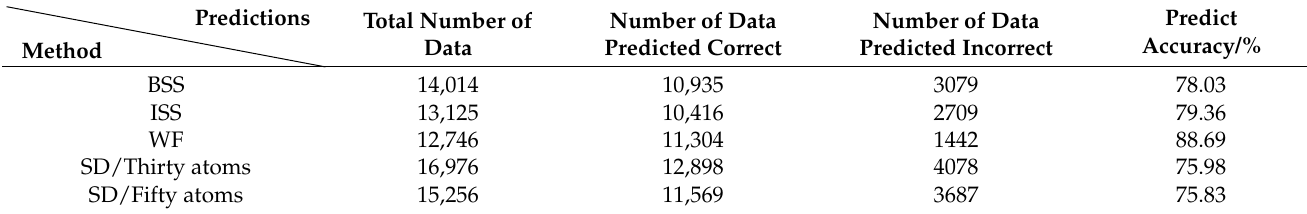
Table 5. Specific descriptions of the prediction results achieved by the Random Forest classifier on the five data sets.